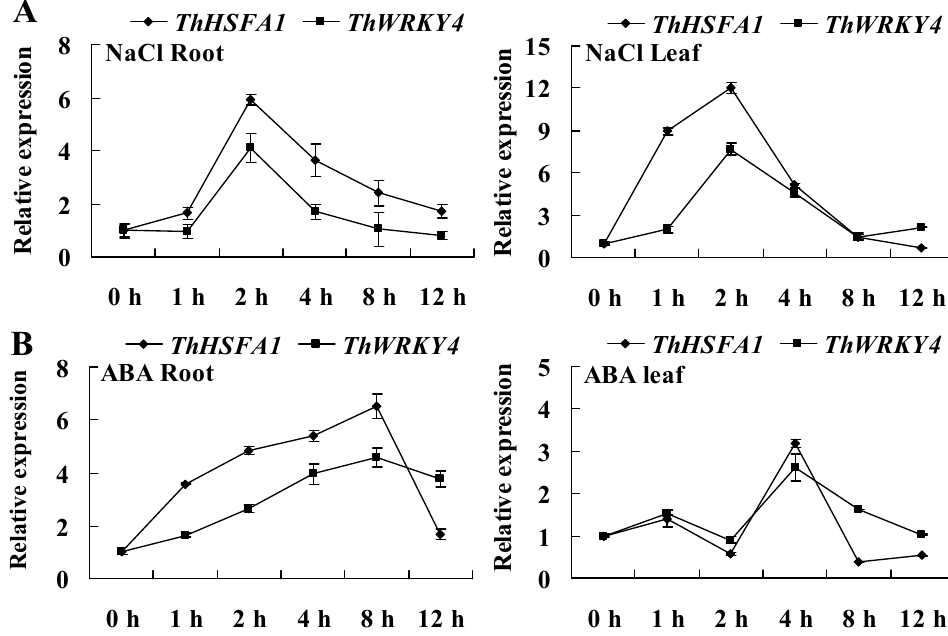
Figure 2. Expression patterns of ThHSFA1 and ThWRKY4 in response to abiotic stress. The transcript levels of ThHSFA1 and ThWRKY4 in roots and leaves from T . hispida seedlings treated with 300 mM NaCl ( A ) or 120 µ M ABA ( B ) for the indicated times were measured by RT-qPCR. A fresh water only-treated control was established in parallel. The reference gene Thtubulin was used as an internal control. The error bars represent ± SD, which were calculated from multiple biological replicates.